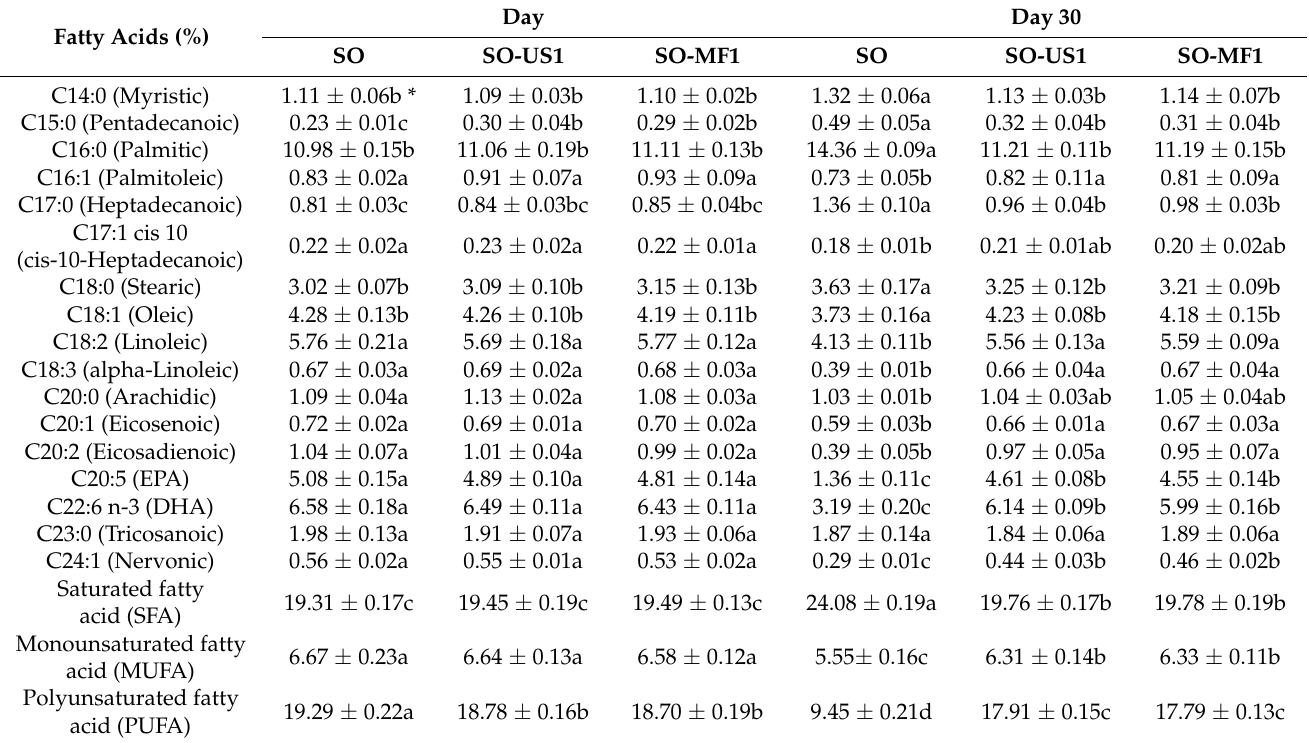
Table 3. Fatty acid profile of SO and SO extracted from US1 and MF1 on day 0 and day 30 of storage at room temperature (28–30 ◦